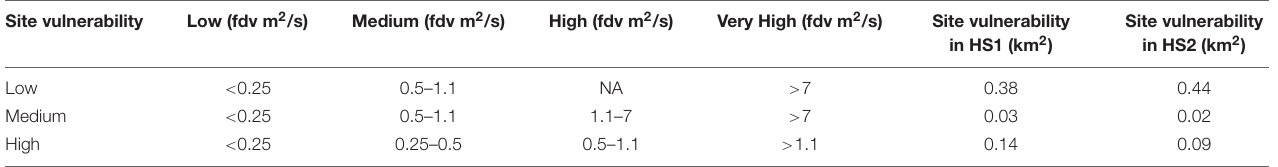
TABLE 5 | Site vulnerability classes and related impact thresholds according to fdv values for the risk to life assessment on the basis of the risk to life matrix (Priest et al., 2007; Christie et al., 2018).